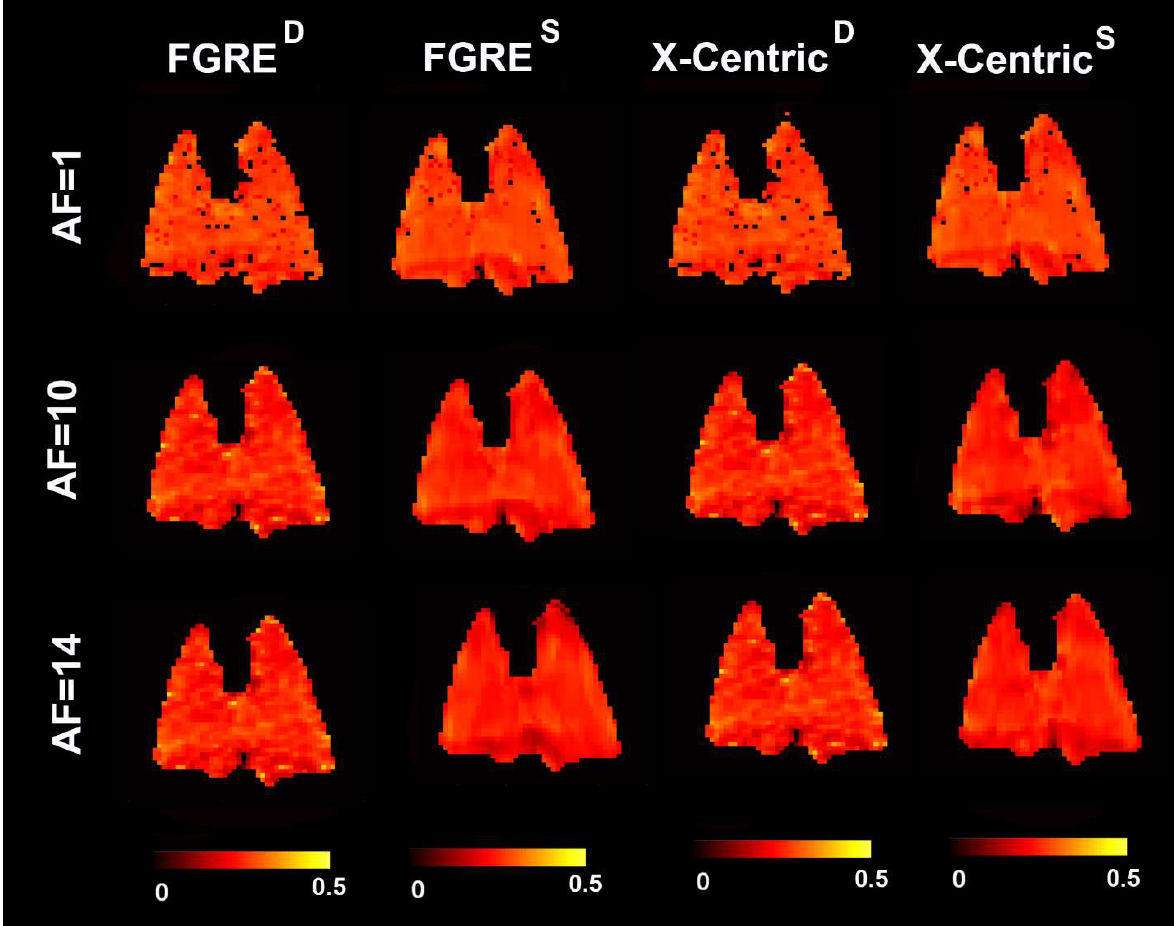
Figure 5. Representative 129 Xe MRI-based fractional ventilation maps generated by using the Deninger method ( D ) and the SEM ( S ) from normal animal using two different imaging approaches (FGRE and X-Centric). The top panel shows fractional ventilation maps calculated for the original fully sampled k-space. The middle and bottom panels show the maps generated for the retrospectively under-sampled data mimicking AF = 10 and 14, correspondingly.